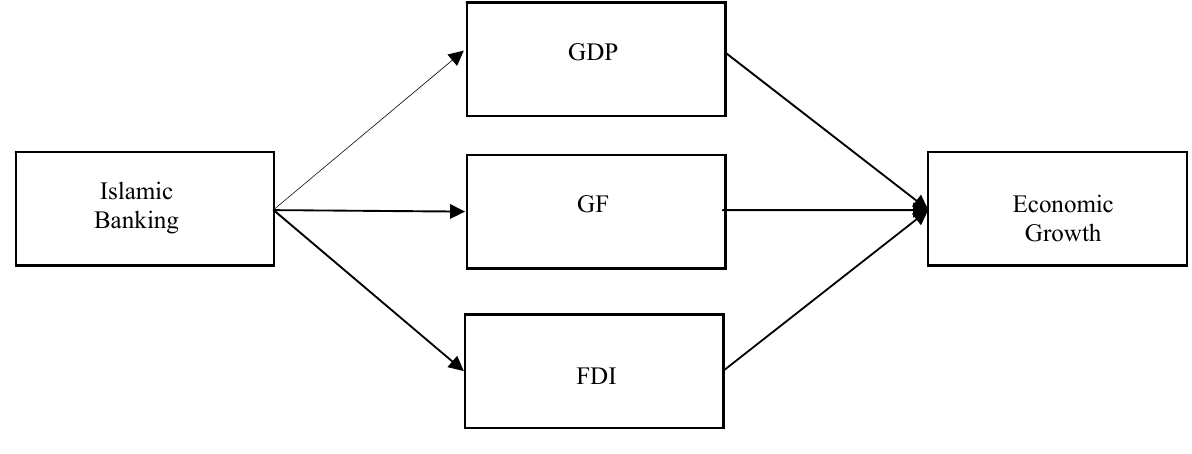
Fig. 2. Study variables